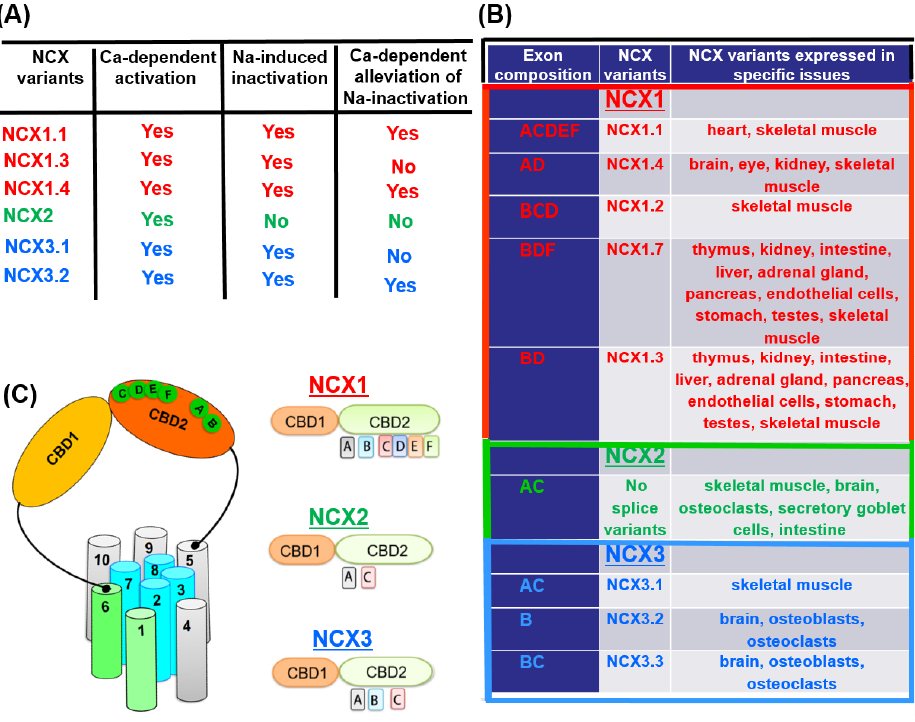
Figure 2. Isoform/splice variants of eukaryotic NCX variants. ( A ) The eukaryotic NCX variants share a mode of Ca 2+ -dependent activation (due to the Ca 2+ binding to CBD1). NCX1 and NCX3 display a mode of Na + -induced inactivation (due to the Na + binding to some unknown site). NCX2 lacks the Na + -induced inactivation mode. The Ca 2+ binding to CBD2 can alleviate the Na + -induced inactivation only in the splice variants of NCX1 and NCX3 that have the Ca 2+ binding sites at CBD2. Exon A generates the Ca 2+ binding sites in CBD2 of NCX1 (but not of NCX3). In contrast, exon B breads the Ca 2+ sites in CBD2 of NCX3 (but not of NCX1). ( B ) The protein products of NCX1, NCX2, and NCX3 genes (isoforms) are expressed in a tissue-specific manner, thereby underscoring diverse regulatory responses of NCX variants to cell-specific Ca 2+ signaling/homeostasis. ( C ) The Ca 2+ -binding regulatory domains, CBD1 and CBD2, form a head-to-tail tandem of two regulatory domains (CBD12). The alternatively spliced region is located exclusively with CBD2. The splice variants of NCX1 and NCX3 arise from a combination of six small exons (A, B, C, D, E and F), where a mutually exclusive exon (either A or B) appears in every splice variant in different combinations of the cassette exons (C, D, E, F). NCX2 contains exons A and C, although no splice variants were found for